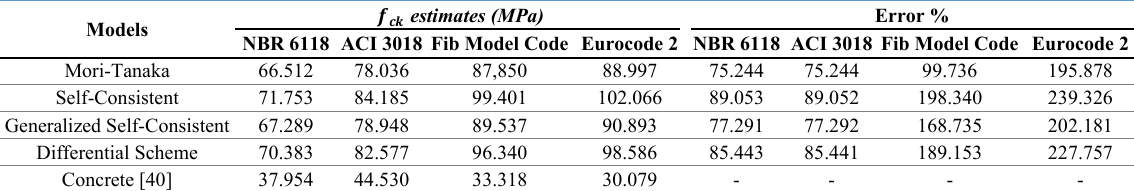
estimated using empirical models and homogenization (Level 6). Table 11: 𝑓𝑓 𝑐𝑐𝑐𝑐 Models